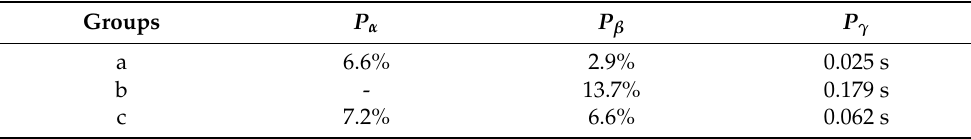
Table 4. Calculation results of the accuracy